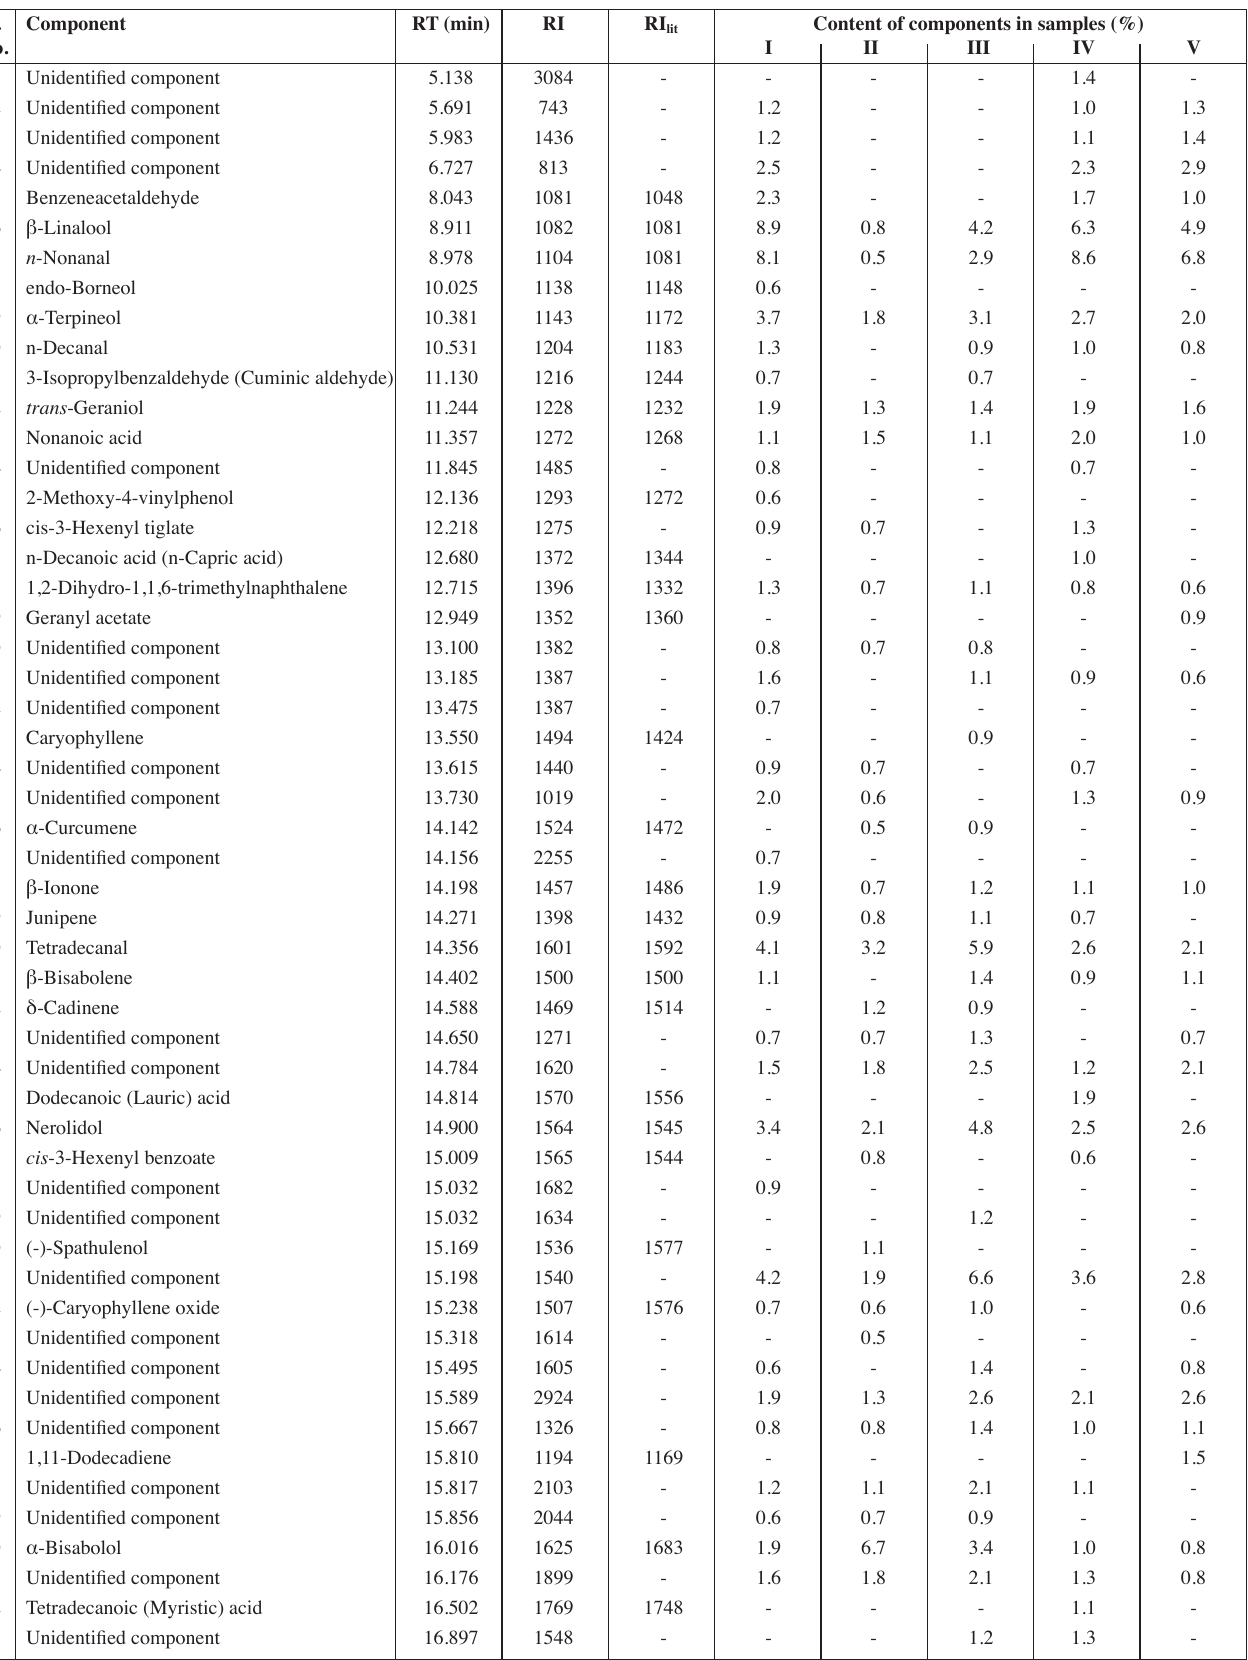
Tab. 2: Percentage composition of the essential oil from leaves of F. viridis Weston Sr. Component RT (min) RI RI lit Content of components in samples (%)